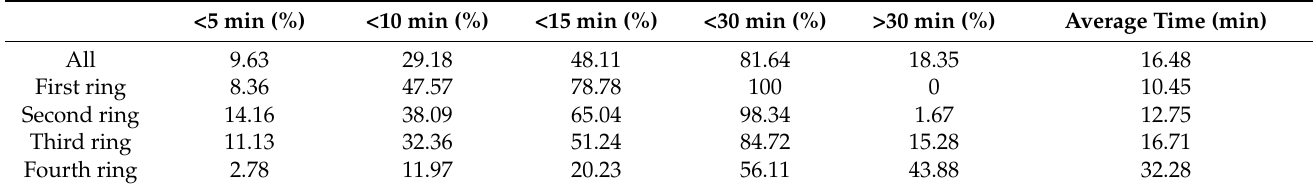
Figure 5. Accessibility measurement after the OSD allocation (Created by the authors). Table 3. Healthcare service coverage statistics after the OSD allocation at different time thresholds on each ring